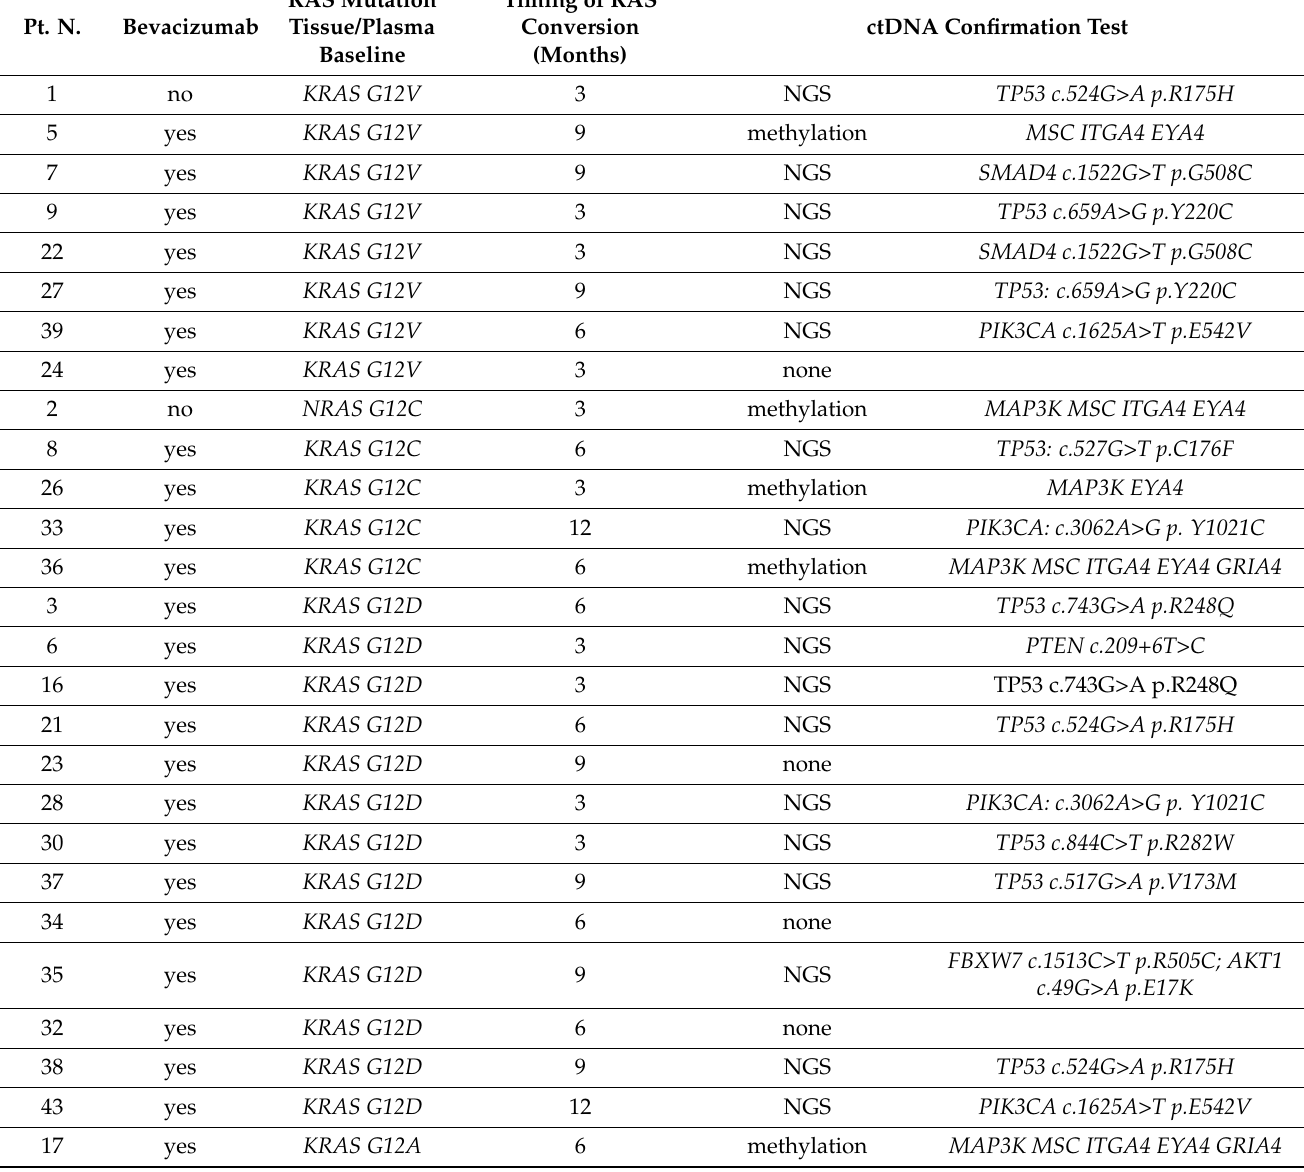
Table 2. Timing of RAS conversion and ctDNA confirmation